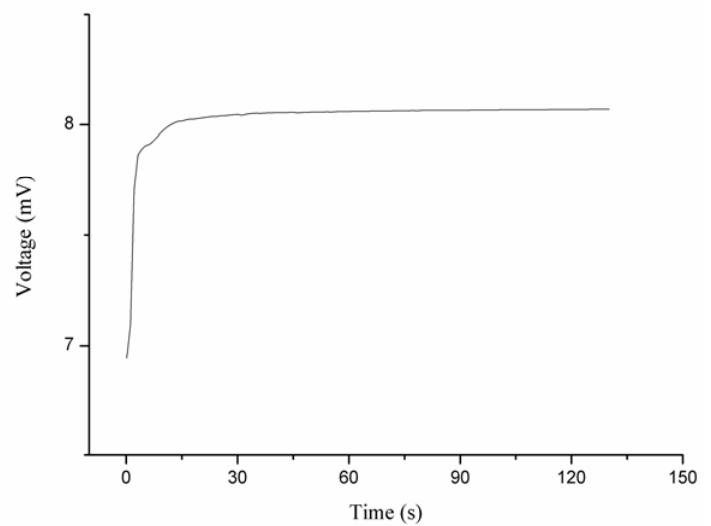
Figure 3. The response time of the iodide ion sensor for 1 × 10 − 6 M potassium iodide solution.